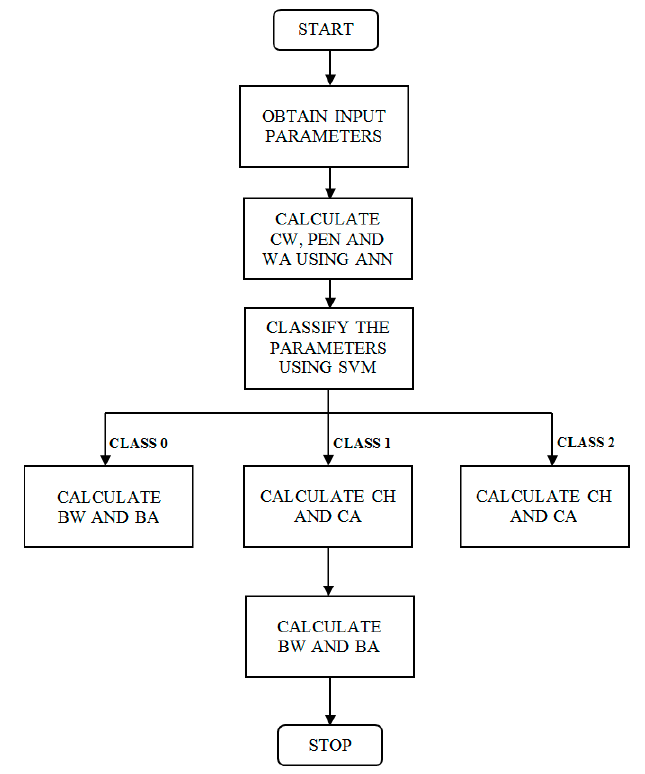
Figure 4. Flowchart of the two-stage SVM–ANN algorithm to predict bead geometry.